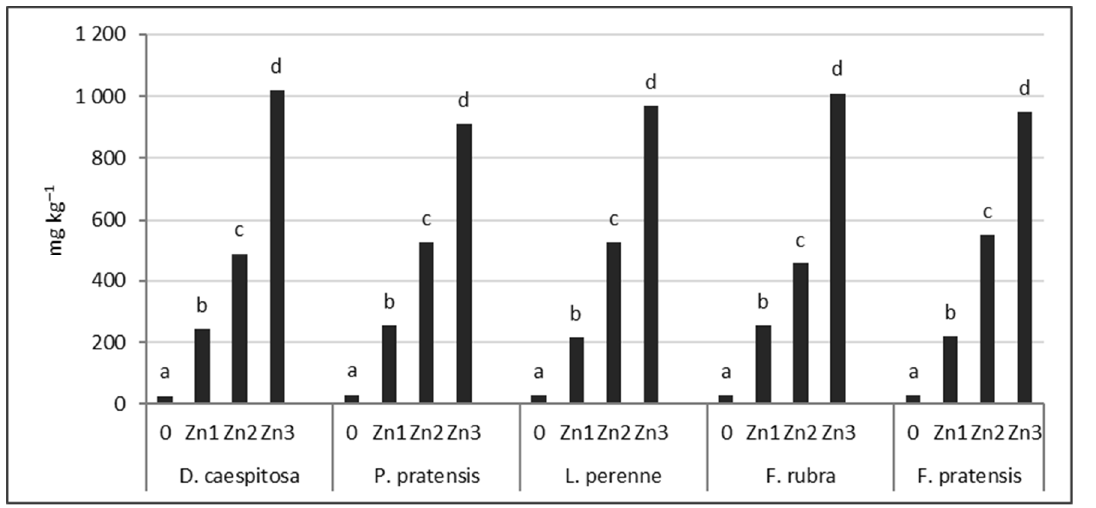
Figure 5. Zn concentration in soil after harvest. Values marked with the same letters within one species do not differ significantly, according to Tukey’s test ( p < 0.05).